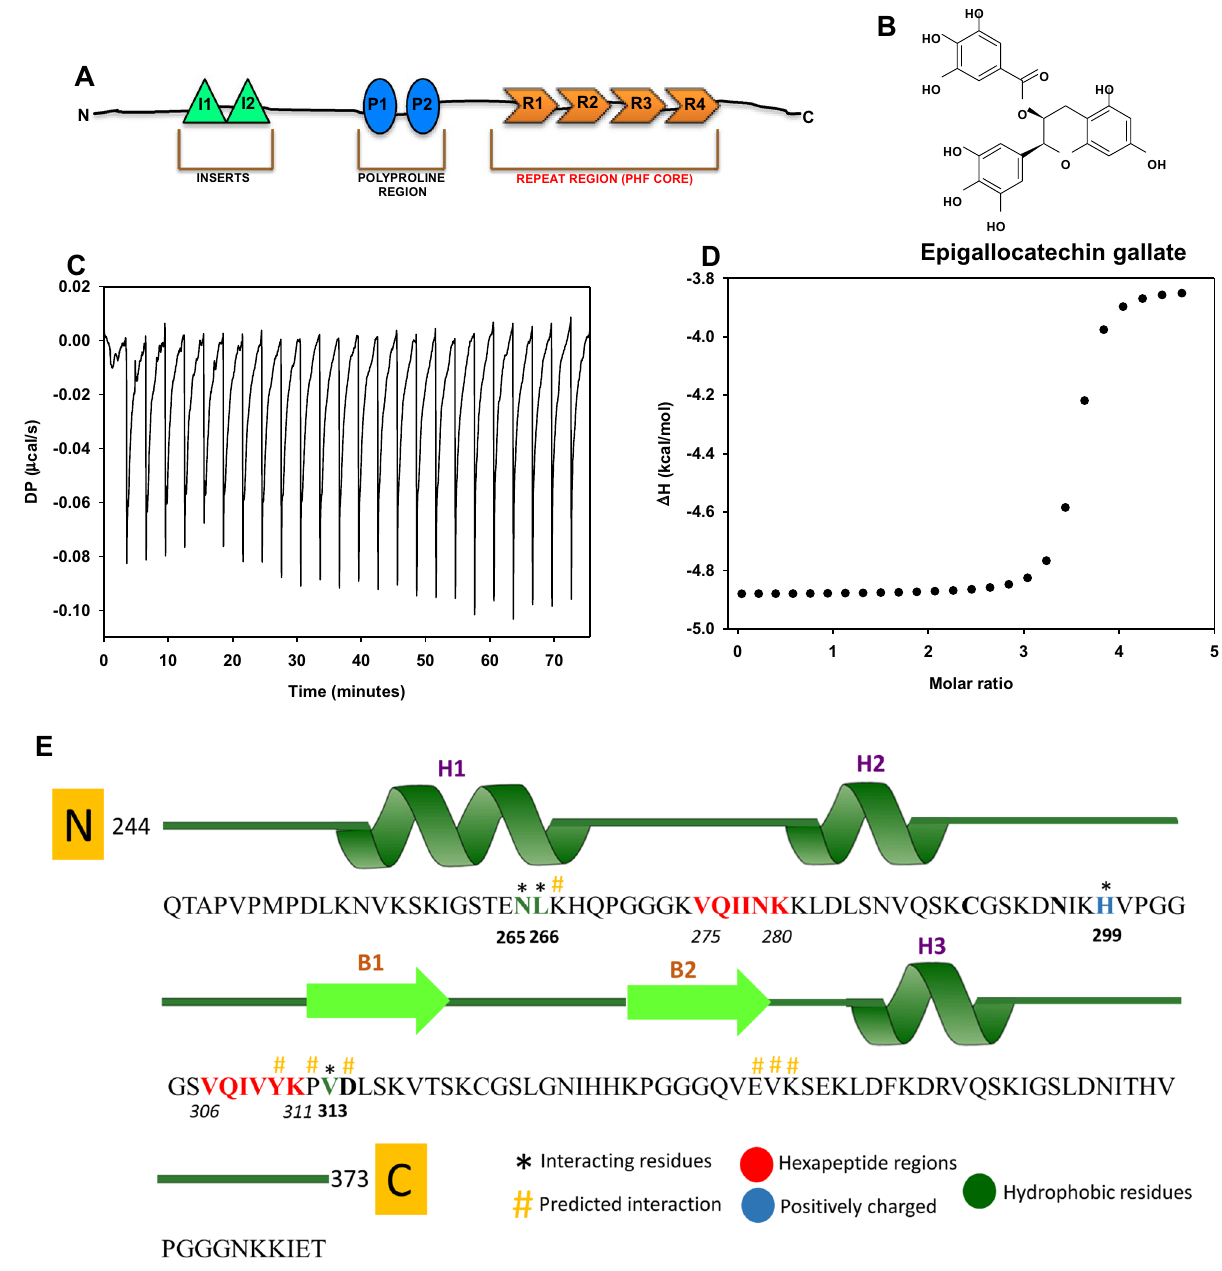
Figure 1. The interaction and binding affinity of Tau and EGCG. ( A ) Tau domain organization. ( B ) The structure of polyphenol EGCG. ( C ) Isothermal titration calorimetry carried out for 20 μM full-length Tau and 500 μM EGCG shows multi-site binding between the two. ( D ) The heat plot for Tau-EGCG interaction suggests n = 3.5 binding sites. Thus, there are more than one binding events involved in Tau-EGCG interaction. ( E ) A schematic diagram of the Tau K18 model depicting three predicted alpha helices (H1, H2, and H3) and two predicted beta sheets (B1, B2) with two distinct and characteristic hexa-peptide regions 275 VQIINK 280 and 306 VQIVYK 311 . The predicted ligand interacting residues, color coded according to their type of interaction is also